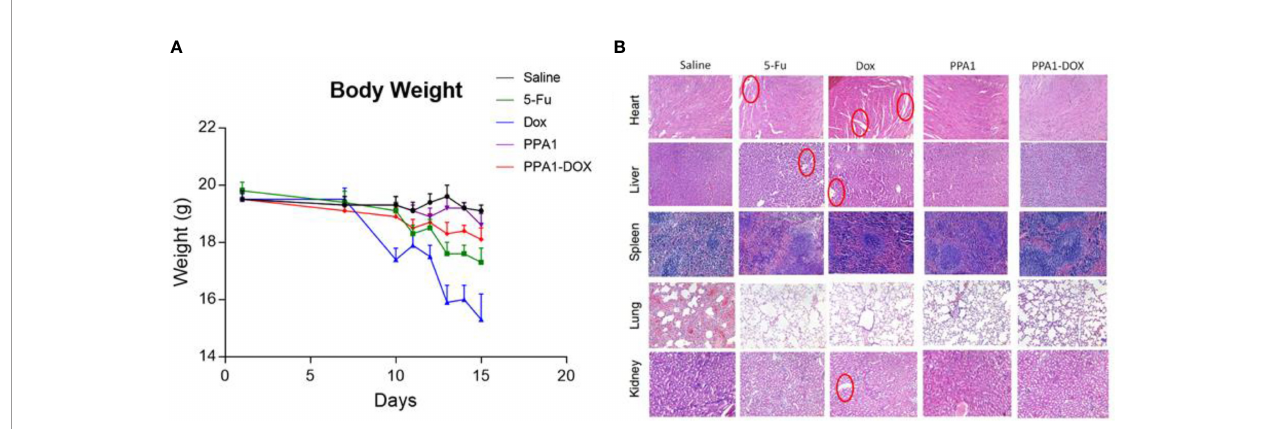
FIGURE 4 | The toxicity of PPA1-DOX for treating CT26-bearing mice. (A) The body weight analysis of 5 groups of treatment at a dosing frequency of twice a week via intraperitoneal injection. (B) H&E staining analysis of individual tissues from 5 respective treatment groups. The cytoplasmic vacuolation and loss of myo fi brillar were observed in heart damage in 5-Fu and Dox groups. For liver damage, hepatic cords loss, mild steatosis, and dilatation of blood sinus were observed in 5-Fu and Dox groups. All the damages were highlighted in red circles. Scale bars, 100 m m. The data were represented by means ± SEM. n =